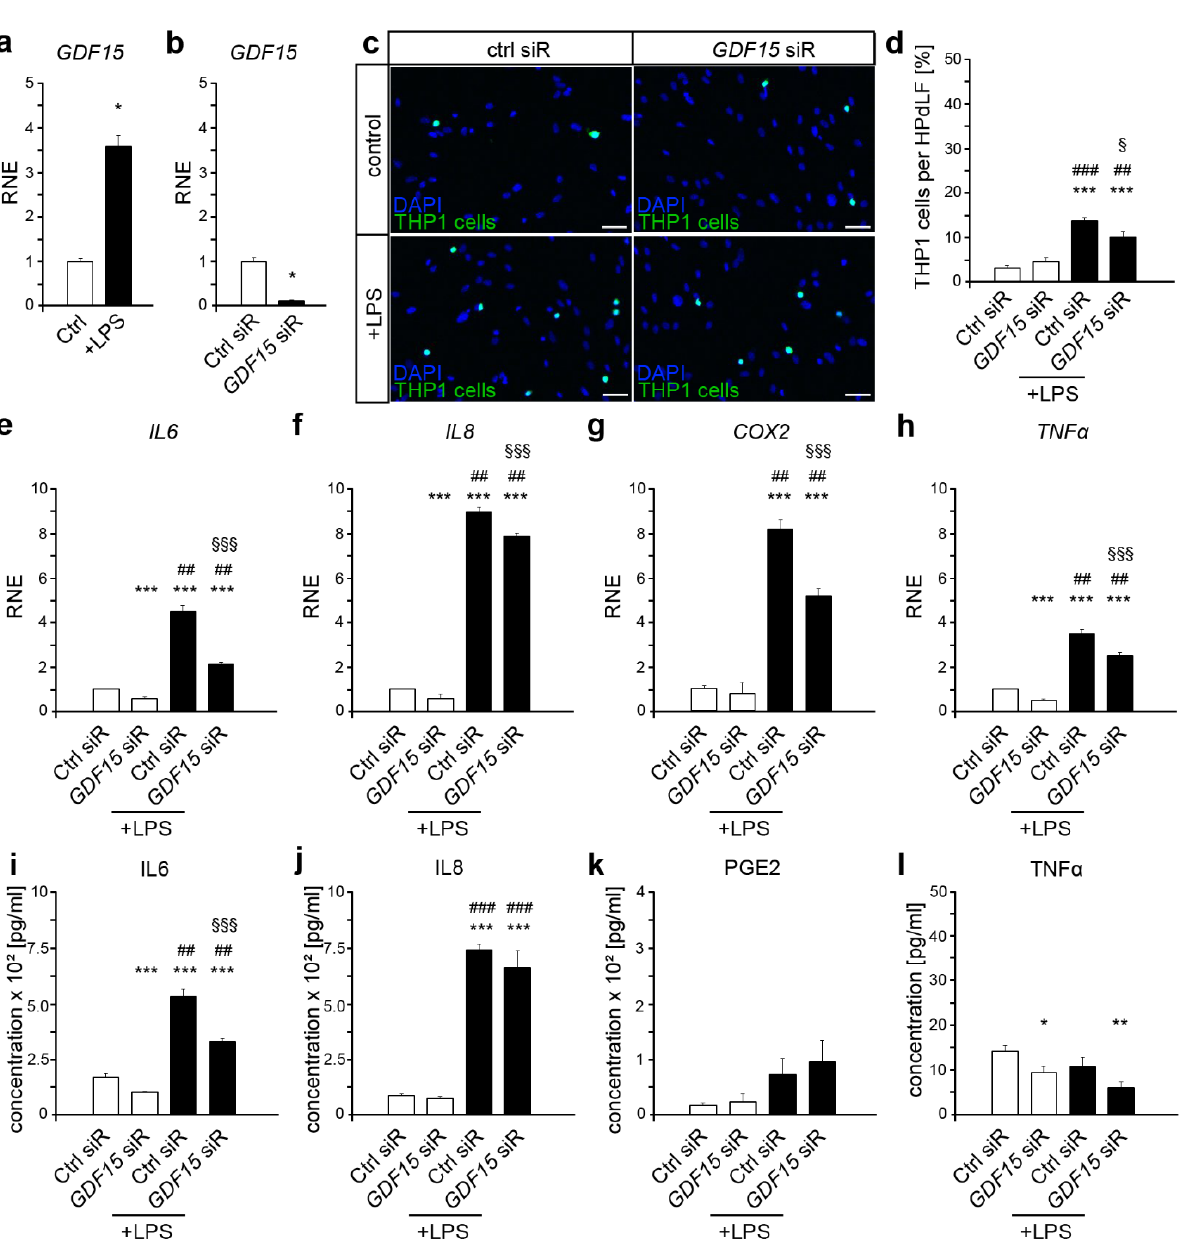
Figure 1. GDF15 promote the inflammatory response of HPdLF to lipopolysaccharides of P. gingivalis . ( a ) Quantitative analysis of GDF15 expression in HPdLF stimulated with 10 µg/ml P. gingivalis LPS for 24 hours. ( b ) Validation of GDF15 knockdown by quantitative analysis of GDF15 expression level in HPdLF treated with GDF15 siRNA ( GDF15 siR) or Control siRNA (Ctrl siR). ( c , d ) Analysis of adherent THP1 monocytic cells (green, Alexa488-gelabled) on HPdLF (blue, DAPI) after GDF15 knockdown as well as stimulation with P. gingivalis LPS ( c ). The relative number of THP1 cells is displayed per 100 HPdLF in ( d ). ( e – h ) Quantitative expression analysis of the inflammatory genes IL6 ( e ), IL8 ( f ), COX2 ( g ) and TNF α ( h ) in GDF15 -deficient HPdLF additionally stimulated with P. gingivalis LPS. ( i – l ) Analysis of secreted